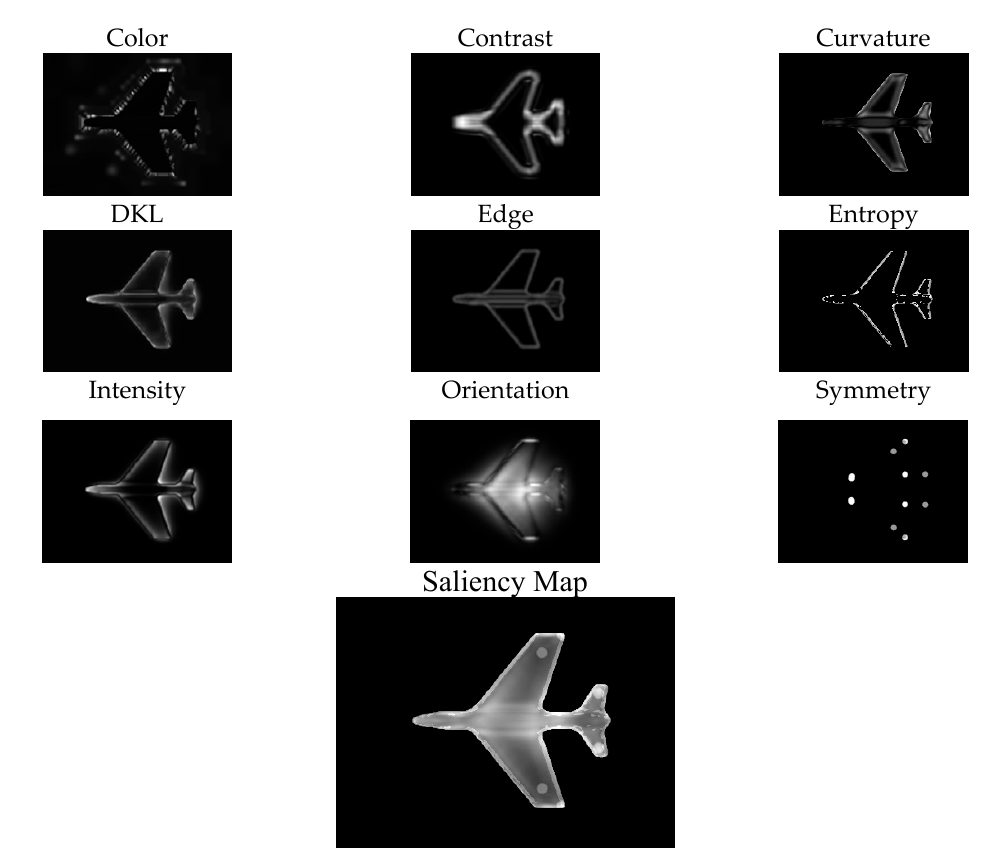
Figure 4. The nine channels contributing to the model of visual attention.